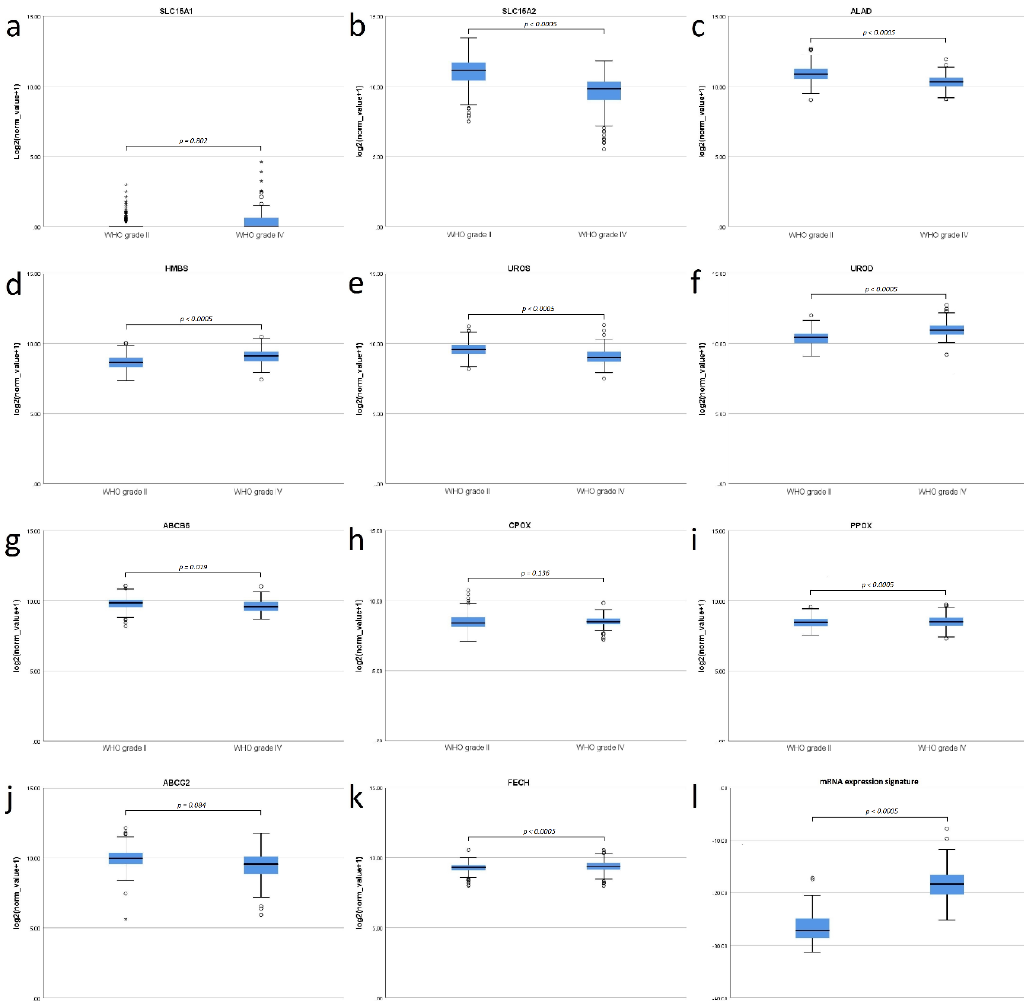
Figure 2. Boxplot diagrams comparing the mRNA expression of relevant factors of the heme biosynthesis pathway between WHO grade II and WHO grade IV gliomas on logarithmic scales. It is of note that an increase of x on the y -axis corresponds to an 2x-fold increase of detected copy numbers. ( a ) No significant difference in SLC15A1 mRNA expression. ( b ) Significantly lower SLC15A2 mRNA expression in WHO grade IV gliomas. ( c ) Significantly lower mRNA expression of ALAD in WHO grade IV